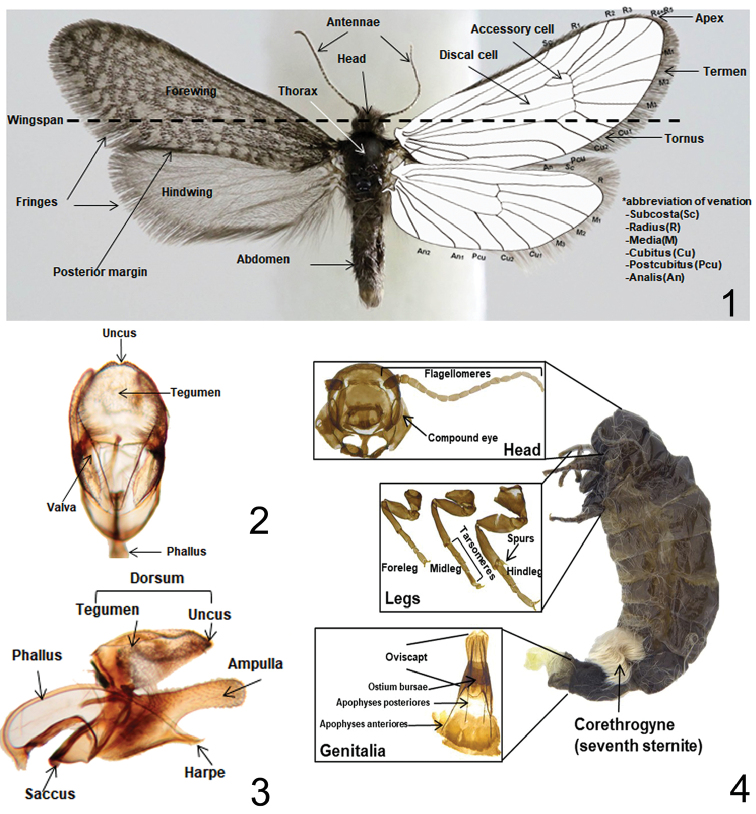
Terminology of morphological characters. 1 Male (Dierl (1964), Arnscheid and Weidlich (2017)) 2 Male genitalia, dorso-ventral part (Dierl (1964), Kristensen (2003) and Arnscheid and Weidlich (2017)) 3 Ditto, lateral part (Dierl (1964), Kristensen (2003) and Arnscheid and Weidlich (2017)) 4 Female (Arnscheid and Weidlich (2017)).